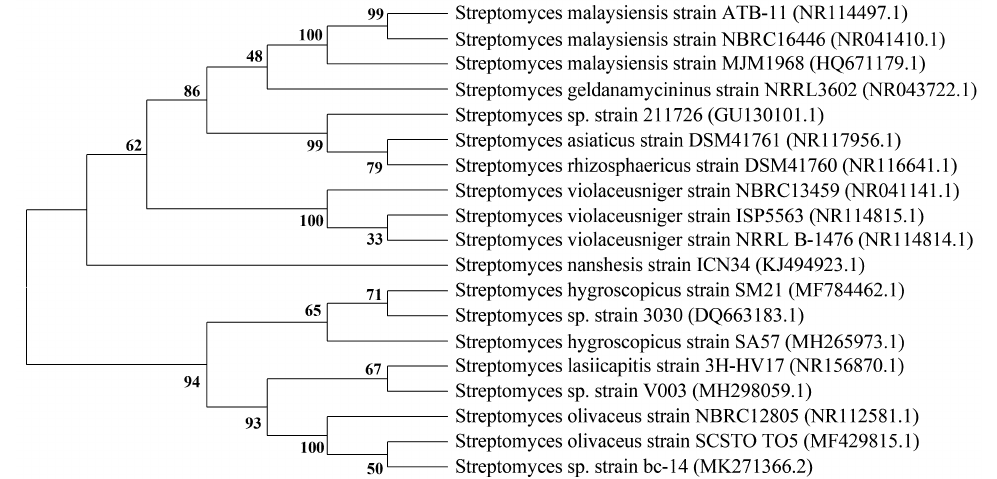
Figure 4. Neighbor-joining tree based on the 16 S rRNA gene sequences of some strains producing guanidine-containing polyhydroxyl macrolide. Some similar strains belonging to the same species of these strains, which have no 16 S rRNA gene sequences, were used.